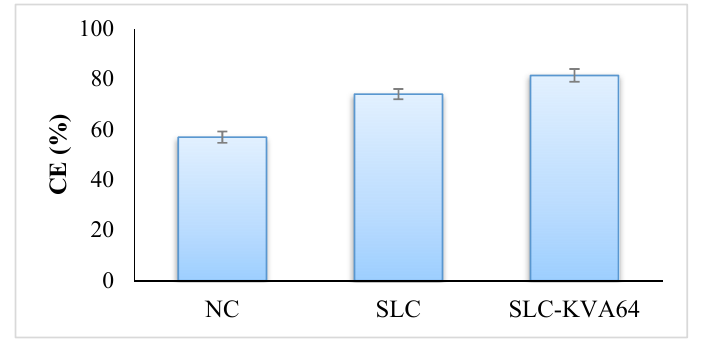
Figure 7. Effect of pure SLC and SLC-KV64 on CE .